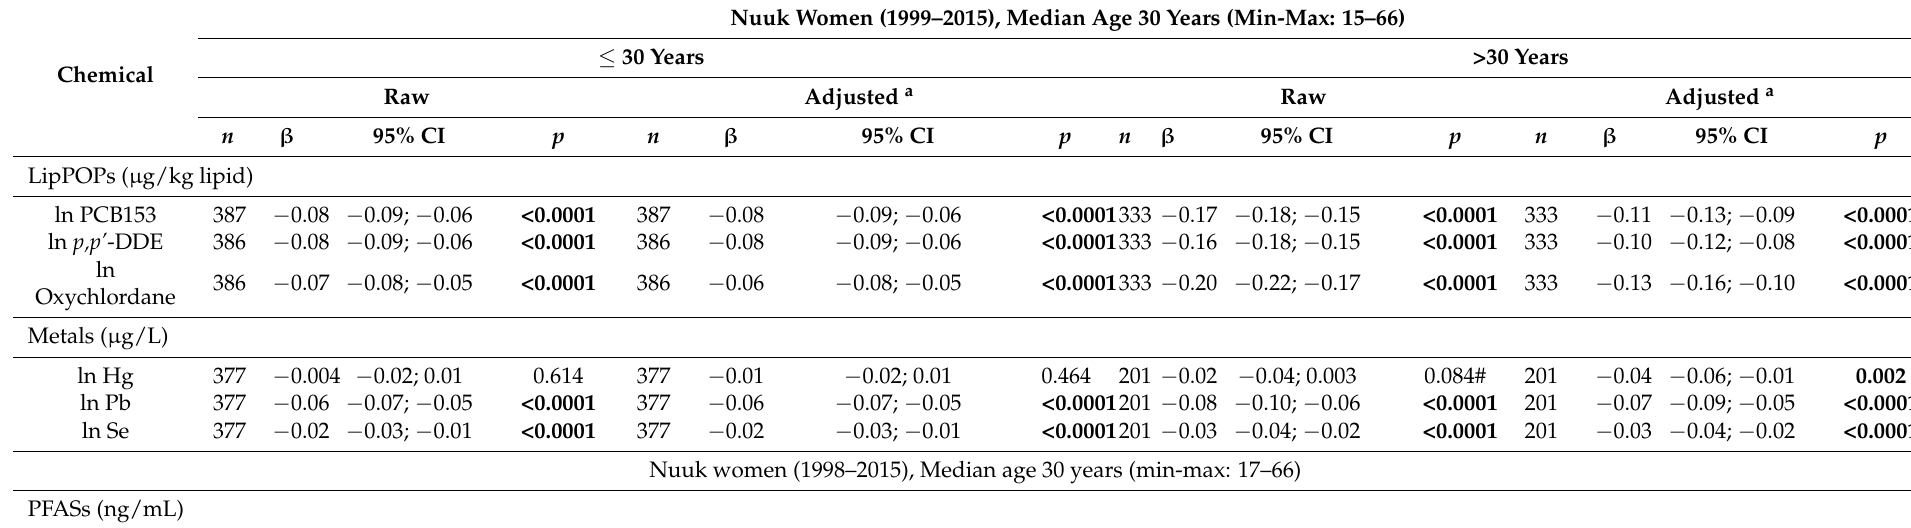
Table 4. Nuuk and Ilulissat women: Age stratified time trend of lipPOPs, metals and PFASs